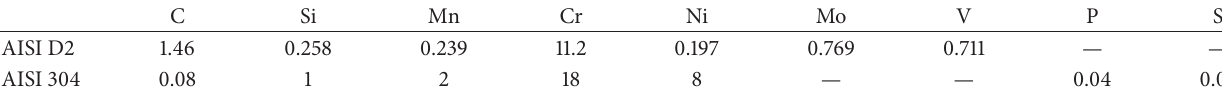
Table 1: Chemical composition (wt%) of AISI D2 tool steel and AISI 304 stainless steel by XRF technique.